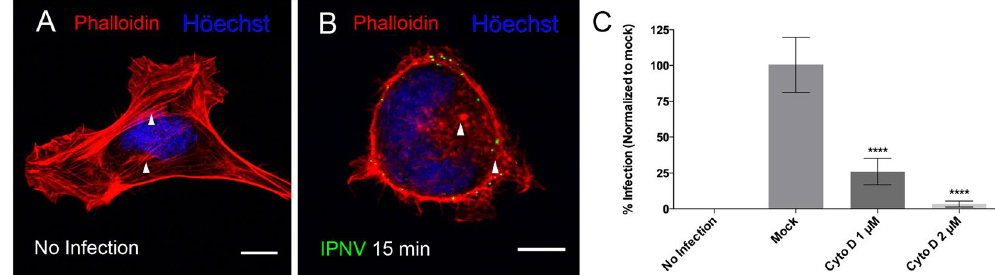
Figure 6. IPNV infection is dependent on actin polymerization dynamics. A. CHSE-214 cells were infected with IPNV at a MOI of 10 and adsorbed for 1 h at 4 °C. The supernatant was removed and MEM medium added at 20 °C. Cells were incubated at 20 °C for 15 min, fixed and stained with rhodamine-conjugated phalloidin. Images were recorded with a C2 Plus Nikon spectral confocal microscope, (scale = 10 μ m). ( A ) no infection ( B ) 15 min post infection (white arrow heads indicate stress fibers in A and disorganized actin in B ). ( C ) CHSE-214 cells were preincubated with 1 or 2 µ M cytochalasin D (Cyto D) for 1 h and infected with IPNV at a MOI of 1 in the presence of Cyto D. Cells were incubated at 20 °C for 6 h and processed by indirect immunofluorescence (IFI) for IPNV VP2/VP3. For each condition, 250 cells were counted. The number of VP2/VP3-expressing cells is shown as a percentage, normalized to mock cells ( **** p <